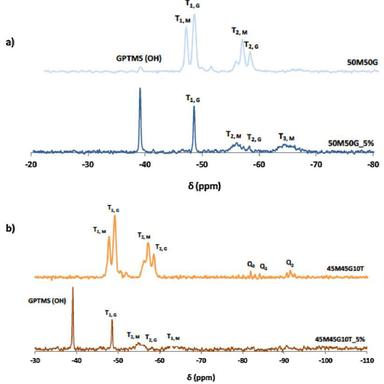
Liquid−state 29Si-NMR spectra of 50M50G and 50M50G_5% (a) and 45M45G10T and 45M45G10T_5% (b) hybrids.